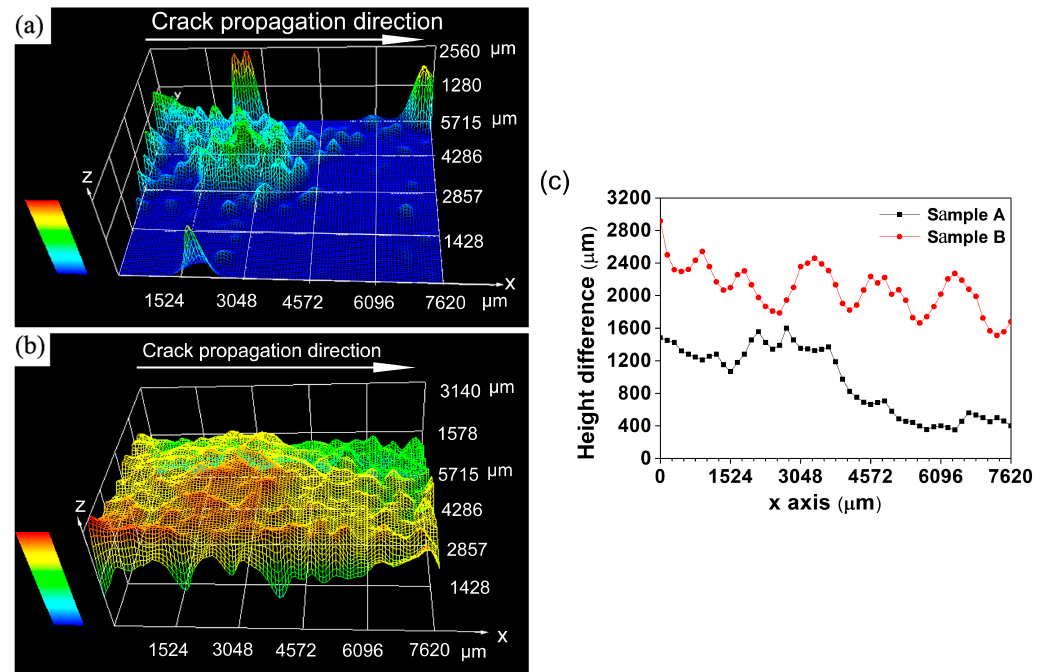
Figure 6. Three-dimensional fatigue fracture surface of sample A ( a ), B ( b ) and height dif0ference between top point and bottom point of samples A and B along the crack propagation direction ( c ).